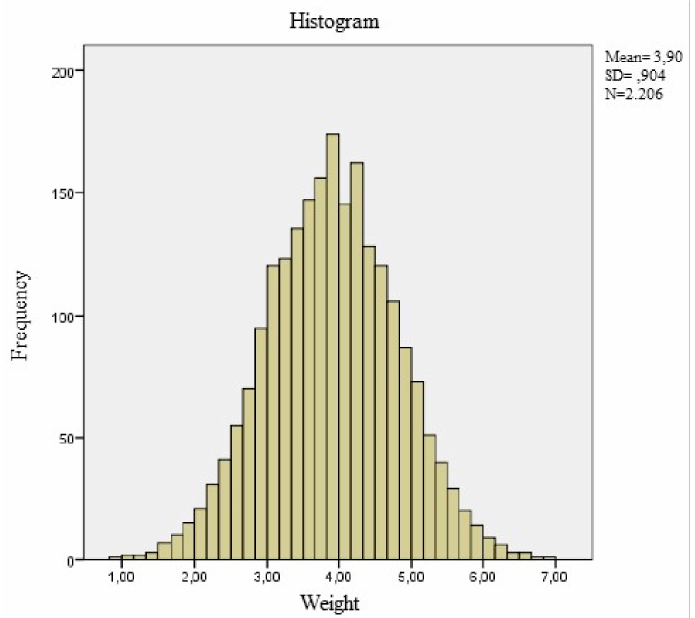
Figure 2. Distribution of the variable the two-step transformation